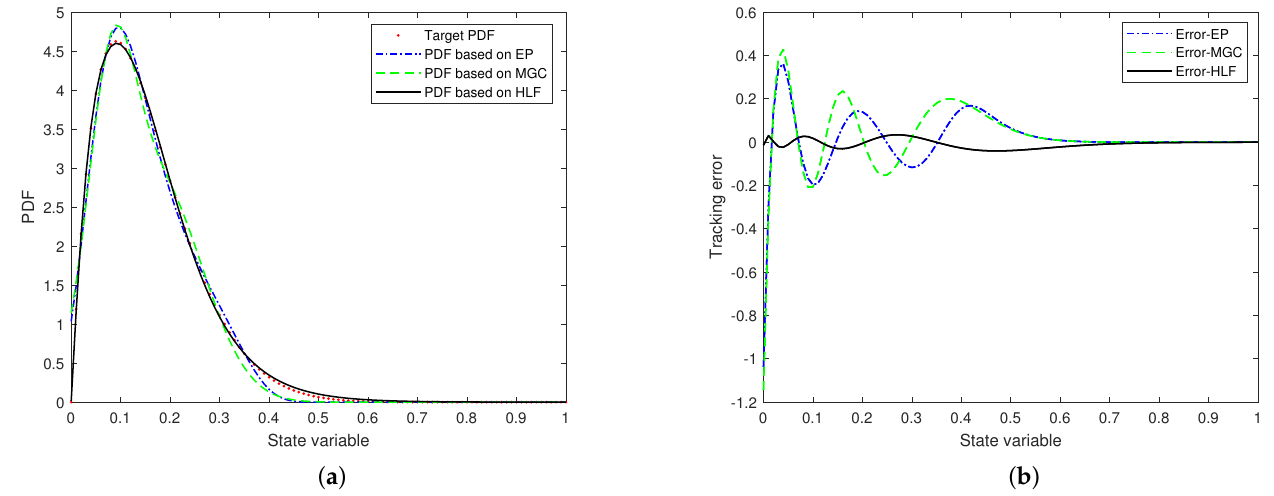
Figure 2. Case 2: unimodal target PDF (beta distribution). ( a ) Control effect. ( b ) Tracking error. (3) Case 3 In Cases 1 and 2, the target PDF only behaves unimodal, whereas the actual system is generally required to be in a multimodal shape. For example, the following target PDF is